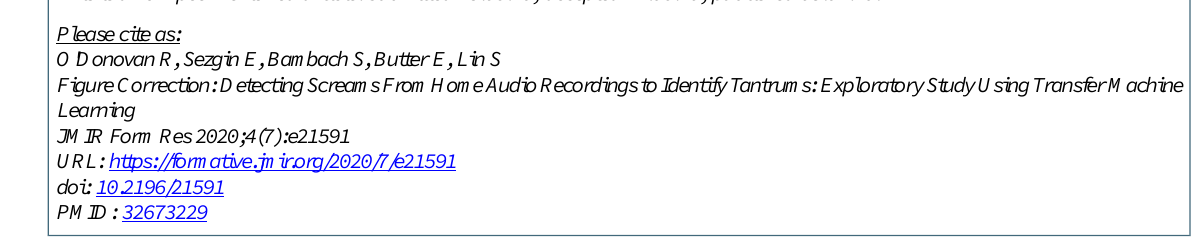
Figure Correction: Detecting Screams From Home Audio Recordings to Identify Tantrums: Exploratory Study Using Transfer Machine